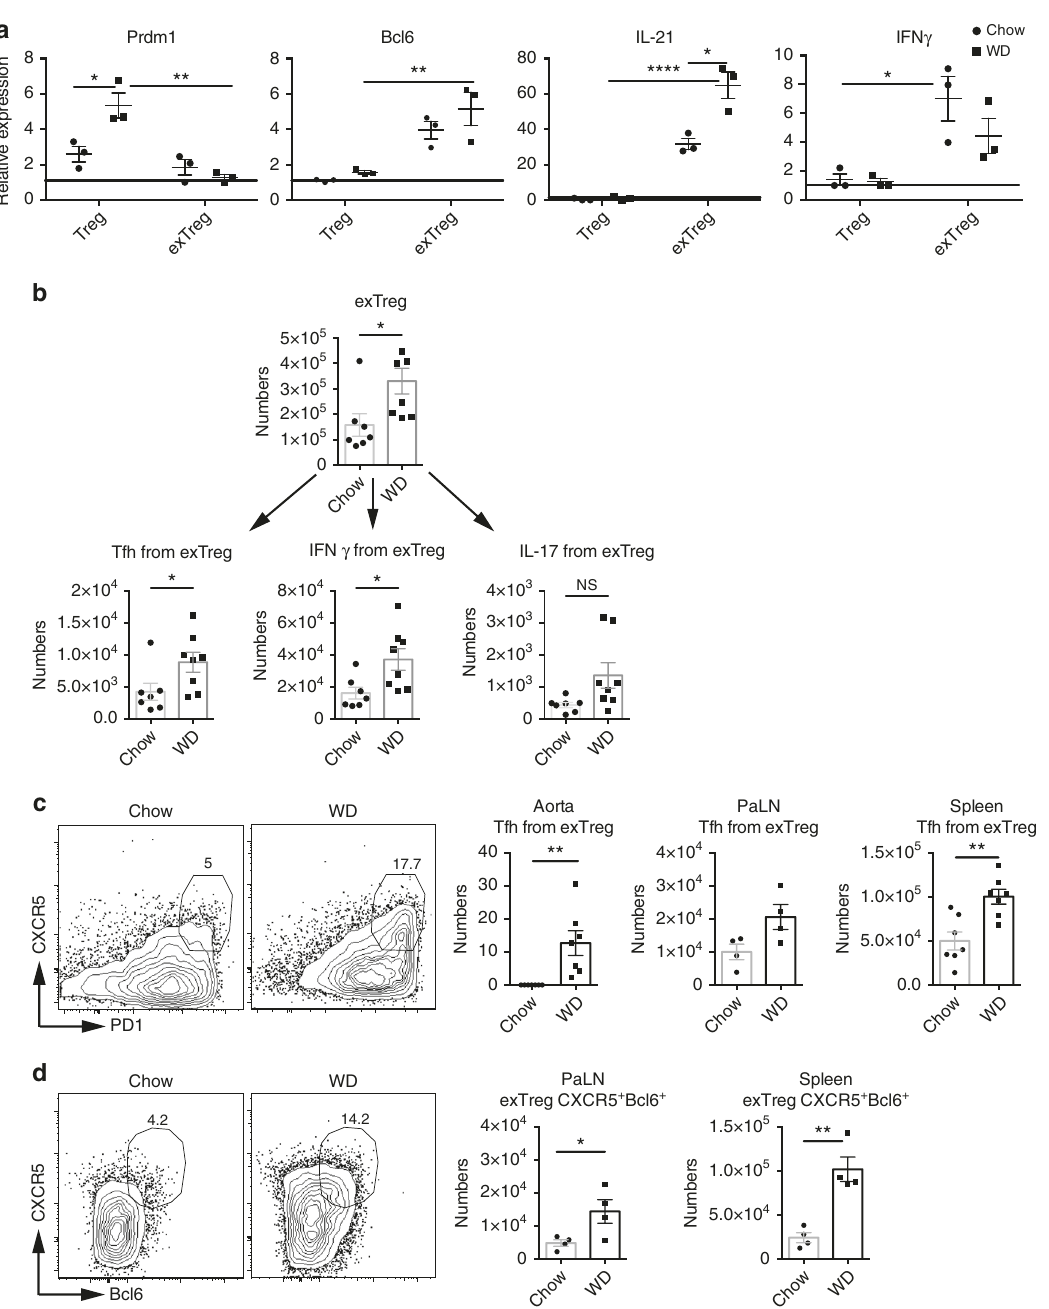
Fig. 2 A portion of exTreg population is converting to T follicular helper cells (Tfh) and Th-1 cells. a The expression of Prdm1 , Bcl6 , Il21 and IFN γ genes by RT- qPCR from RNA extracted from current and exTreg cells sorted from PaLN from chow and western diet-fed LT-ApoE − / − mice. The data were analyzed using the 2 − ΔΔ Ct method and it was normalized to β -actin . b Distribution of different T cell subsets by cell numbers within the exTreg population. Graphs show the number of Tfh, Th1 and Th17 cells within the exTreg population in the PaLN. c Representative fl ow cytometry plots showing the percentages of Tfh (CXCR5 + PD1 + ) exTreg cells in PaLN of above mice. Graphs show numbers of Tfh exTreg cells in the aorta, PaLN and spleens of above mice. d Representative fl ow cytometry plots showing the percentages of Tfh (CXCR5 + Bcl6 + ) exTreg cells in PaLN of above mice. Graphs show numbers of Tfh exTreg cells in the PaLN and spleens of above mice. Results are expressed as mean ± s.e.m. from two independent experiments ( n = 3) ( a ), and mean ± s.e. m from one experiment (n = 7 (chow) and n = 8 (WD)) ( b ), and mean ± s.e.m from one experiment ( n = 7 for aorta and spleen, and n = 4 for PaLN) ( c ), and n = 4 ( d ). Statistical signi fi cant differences were at * P < 0.05, ** P < 0.01, and **** P < 0.0001 (two-way ANOVA followed by Tukey ’ s multiple comparisons test) ( a ) and (unpaired Student ’ s t -test) ( b – d derived from exTreg cells in the aortas, PaLN and spleens of mentary Fig. 1 for gating strategy). In atherosclerosis, we saw western diet-fed mice (Fig. 2c, d). Thus, a signi fi cant portion of Treg increases of 2 – 4 fold in both percentages and numbers of Tfh cells cells converts to Tfh cells during atherosclerosis development.